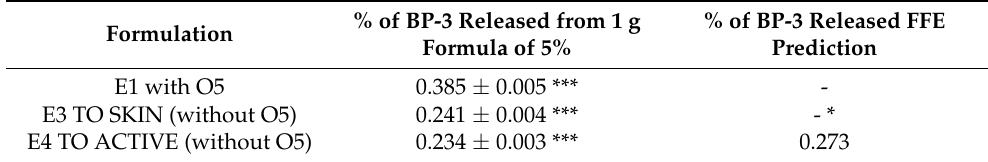
Table 11. Percentage release of BP-3 from E1, E3 and E4. Each value was obtained from four experiments (mean ± SE). *** p <